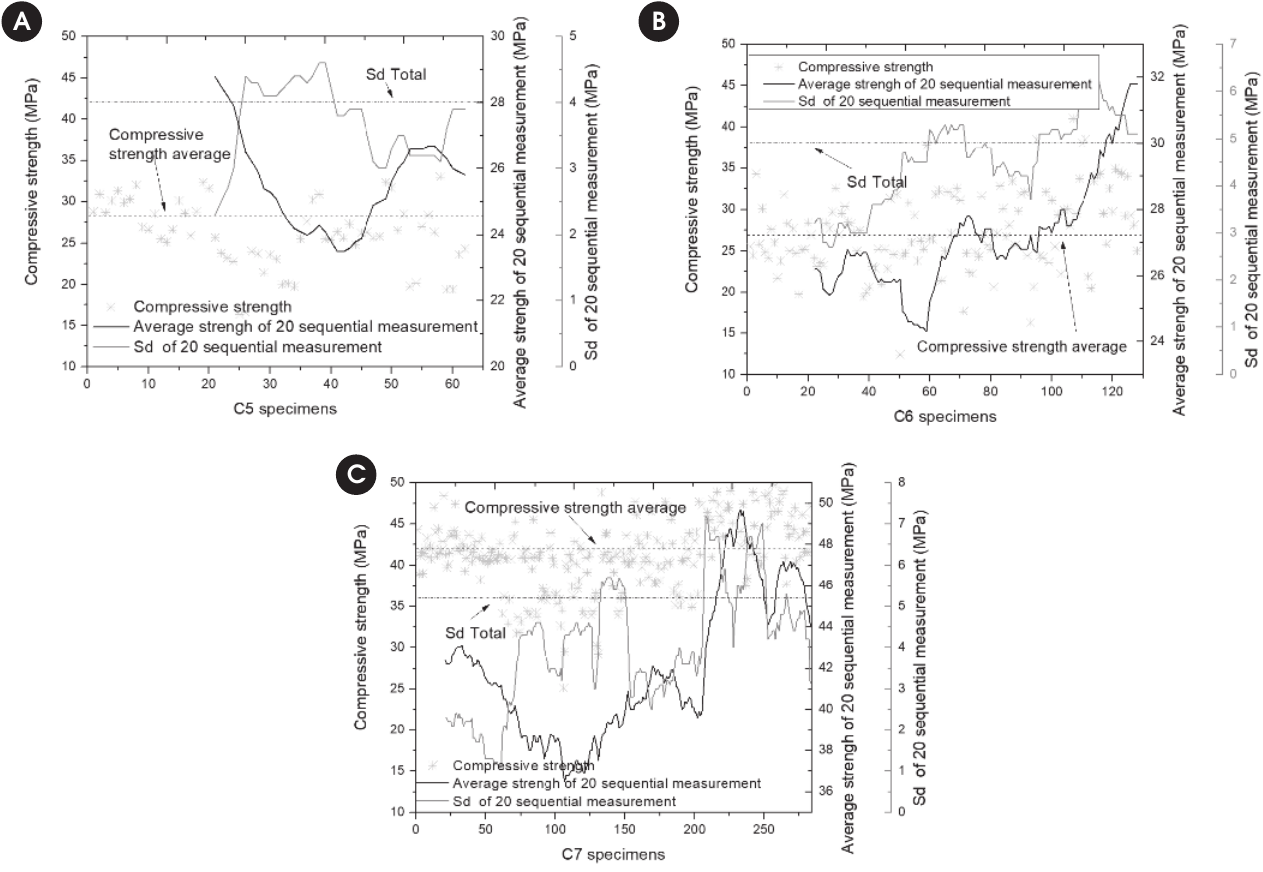
Compressive strength results of C5, C6 and C7